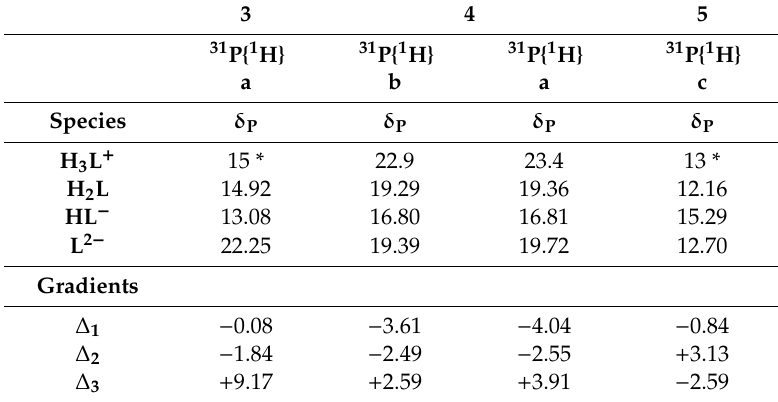
Table 7. Specific chemical shift δ P [ppm] and gradients ∆ [ppm] for compounds 3 to 5 [44]. *) Not iterated. Experimental details for 3 and 4 are given in Table 6. Titrator: a) NaOH; b) TMAOH; c) for 5 were used: C Titrand = 1.6953 mol / L 5 and 3.6935 mol / L TMAOH. Titrator = 0.09993 mol / L HCl.